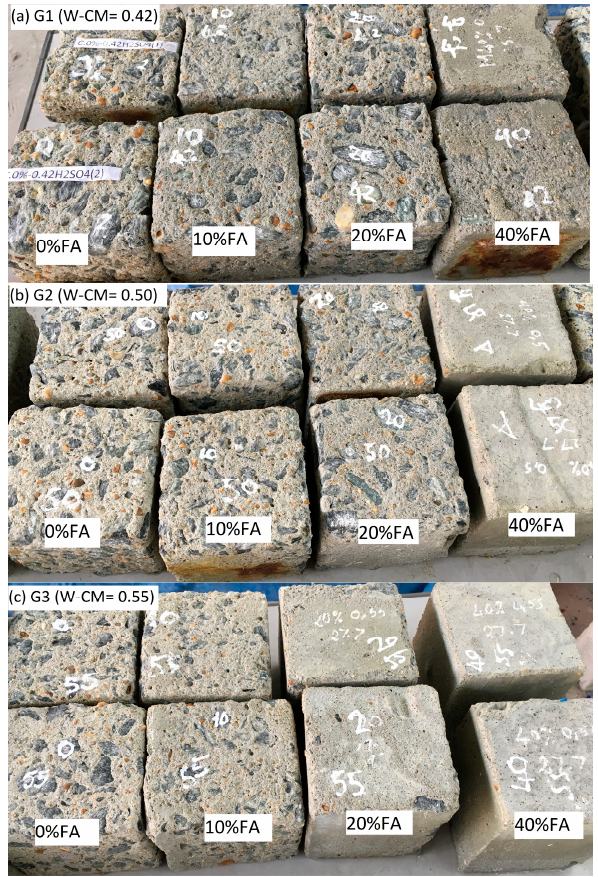
Figure 5. Surface appearance of concrete cubes after immersion in 10% sulfuric acid solution. ( a ) G1 (W–CM = 0.42); ( b ) G2 (W–CM = 0.50); ( c ) G3 (W–CM =